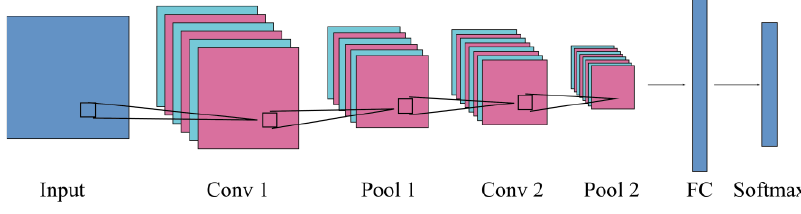
Figure 1. Structure of 2DCNN